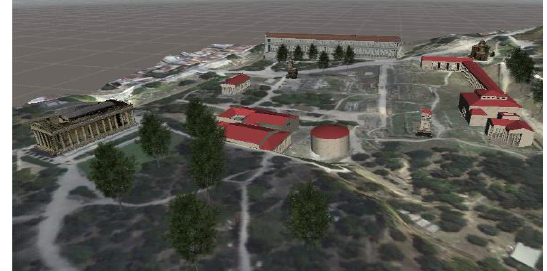
Figure 14: An overview of the game environment